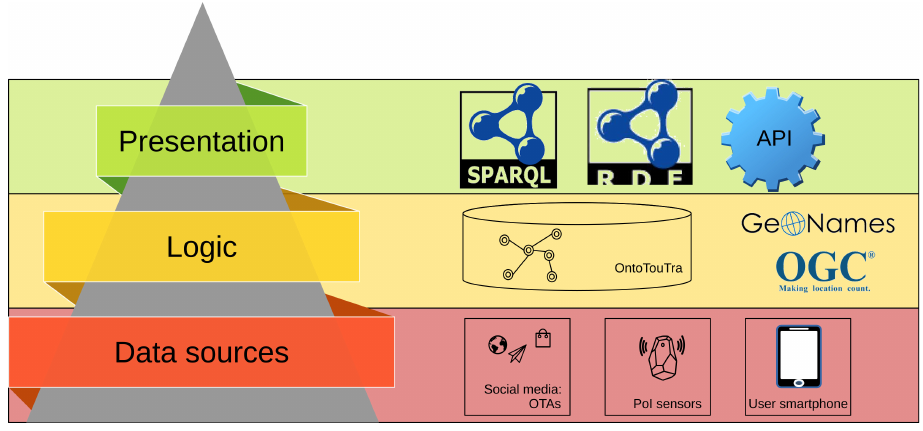
Figure 3. OntoTouTra